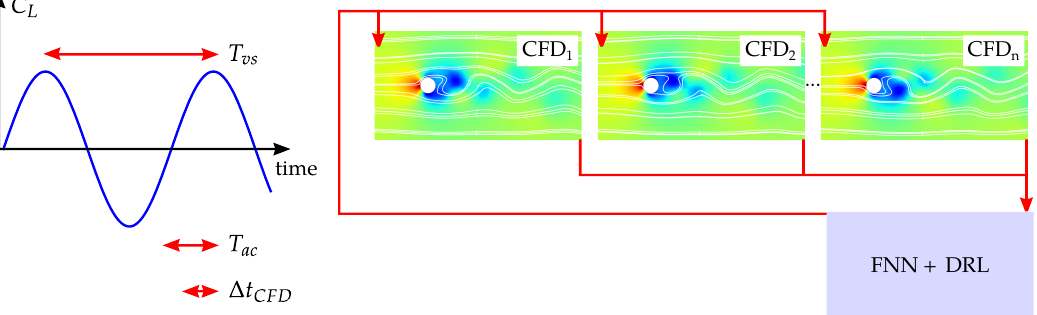
Figure 3. ( Left ) Illustration of different time scales referred to in the text with the vortex shedding period T vs , action time step T ac and CFD time step ∆ t CFD ; and ( Right ) multi-environment scheme of the flow control